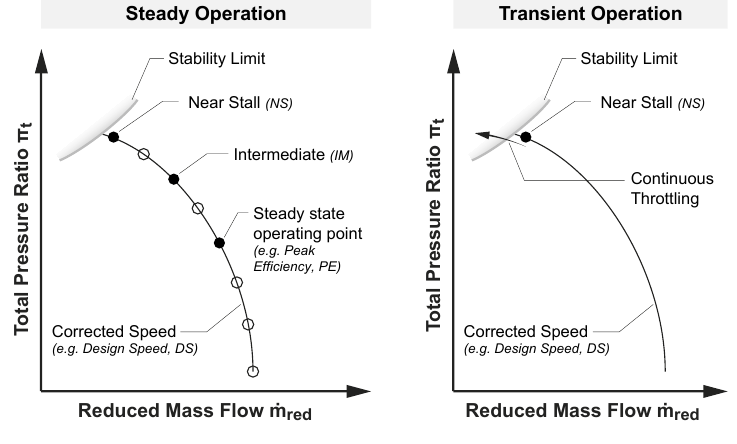
Figure 3. Measurement procedures.